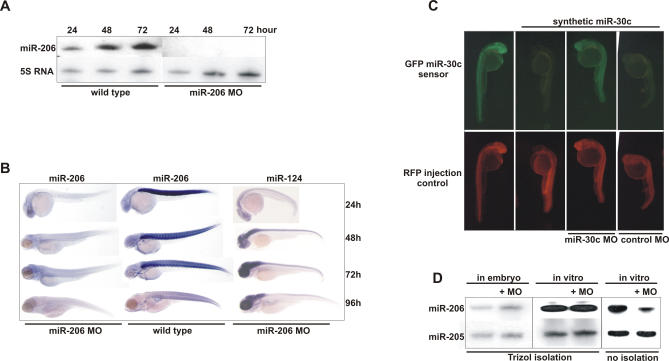
Morpholinos Targeting the Mature miRNA Deplete the Zebrafish Embryo of Specific miRNAs(A) Northern blot for miR-206 in wild-type and MO miR-206–injected embryos at 24, 48, and 72 hpf. 5S RNA serves as a loading control.(B) In situ analysis of miR-206 and miR-124 expression in different stage embryos after injection of MO miR-206.(C) Effect of a morpholino targeting miR-30c on a silencing assay with miR-30c and a responsive GFP sensor construct.(D) In vivo and in vitro effects of a morpholino on the stability and RNA extraction of a synthetic miR-206 duplex. miR-205 serves as a loading control.